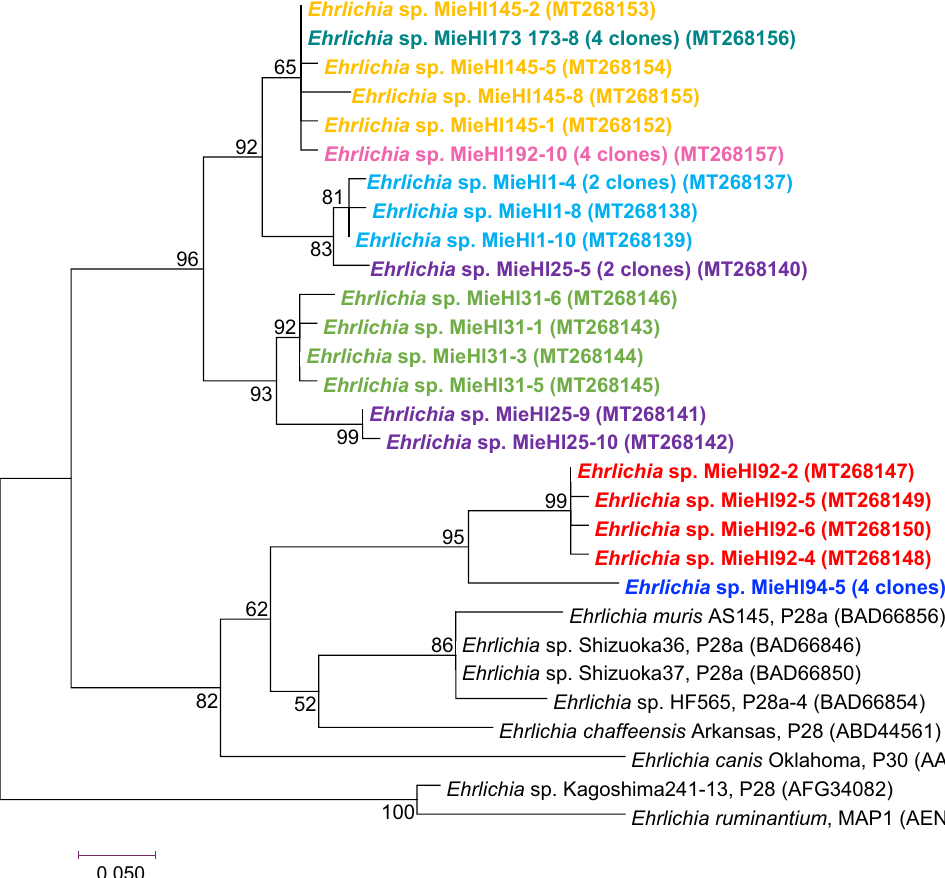
Figure 1. Phylogenetic tree of p28 clones based on 88–91 amino acid sequences from uncultured Ehrlichia bacteria and their close relatives. The tree was constructed using the maximum likelihood method with the Jones–Taylor–Thornton model and “all sites” for gaps/missing data treatment. The numbers on the branch node of the tree indicate bootstrap values from 1000 replications. The scale bar indicates the evolutionary distance. The p28 clones of the uncultured Ehrlichia from a tick individual are indicated by characters with the same color. The accession numbers are in